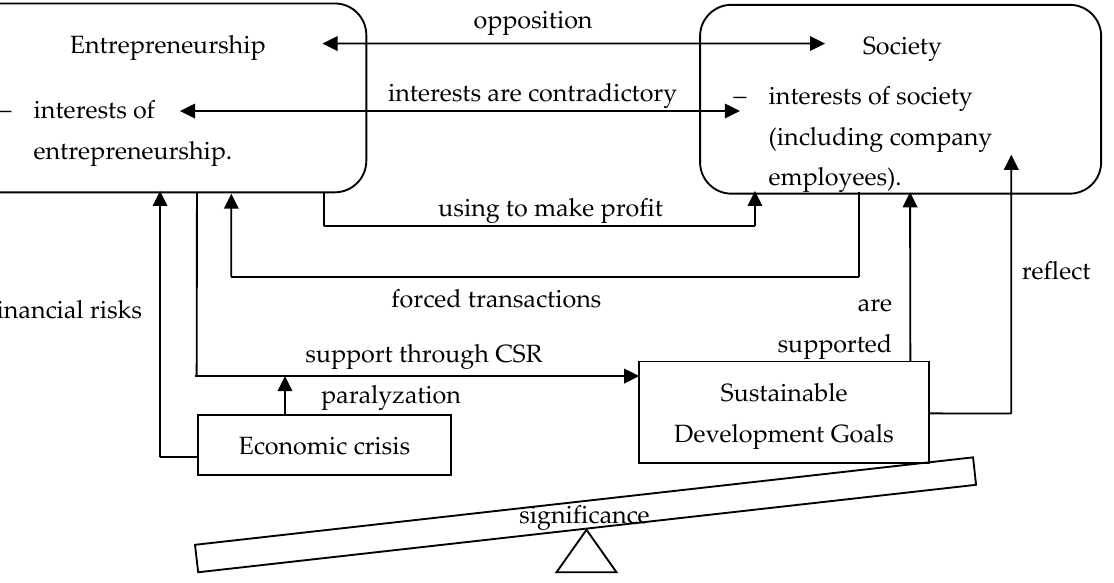
Figure 1. The business-oriented approach to financial risk management in entrepreneurship. Source: authors.